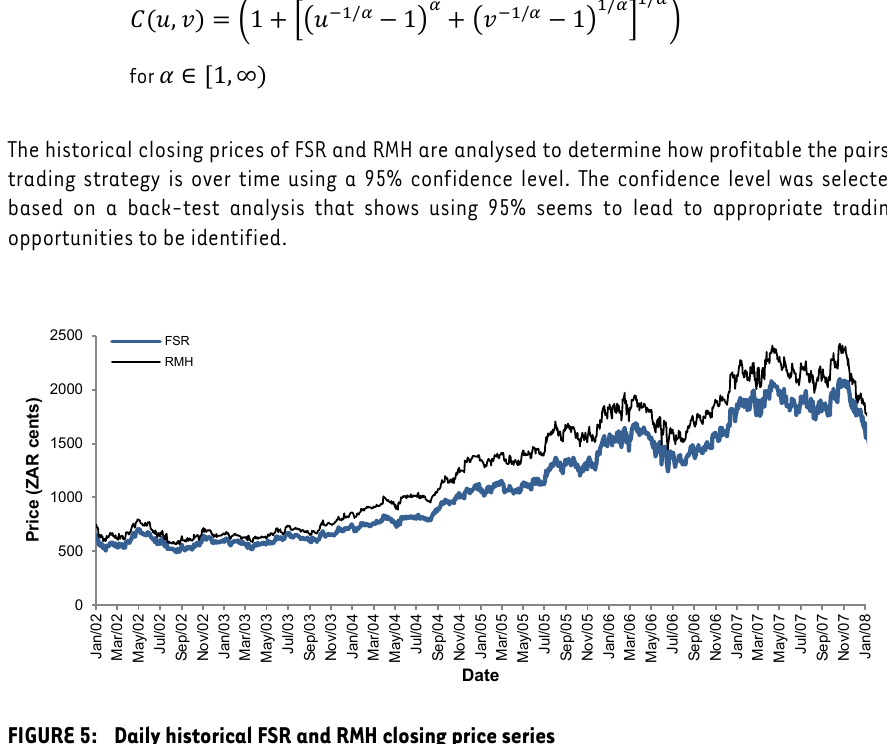
FIGURE 5: Daily historical FSR and RMH closing price series Source: JSE closing